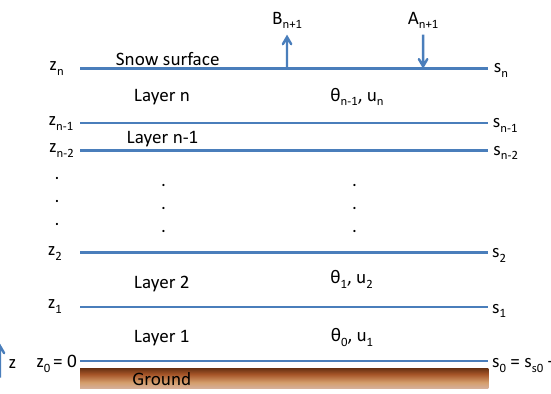
Figure 2. Geometry of the n -layered snowpack with up- and down- welling intensities A and B . Height z j , transmissivity u j of directed radiation, refracted angle θ j − 1 and interface reflectivity s j for layer number j ranging from 1 (bottom) to n (top). Snow–ground reflec- tivity s 0 , consisting of the specular s s0 and diffuse component s d0